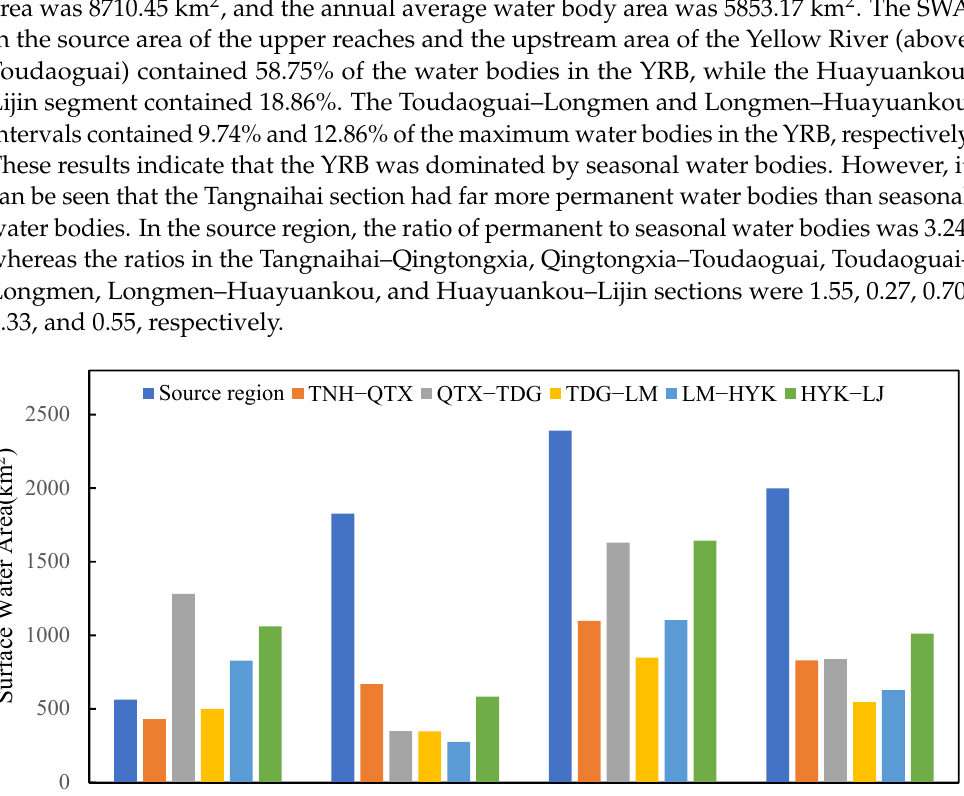
Figure 8. Different types of water bodies in each sub-basin derived from the multi-year average WIF during 1986–2019. Panels ( a – d ) are for the seasonal, permanent, maximum, and annual average water bodies, respectively. 3.3. Changes in the SWA in the YRB from 1986 to 2019 Figure 9 shows the continuous dynamic changes in the different types of water bod- ies—including the seasonal, permanent, maximum, and annual average water bodies—in the entire YRB during 1986–2019. The maximum and seasonal water body areas exhibited typical decreasing trends from 1986 to 2019, but the permanent and annual water areas exhibited slightly increasing trends. The maximum water area varied from 7984.02 km 2 to